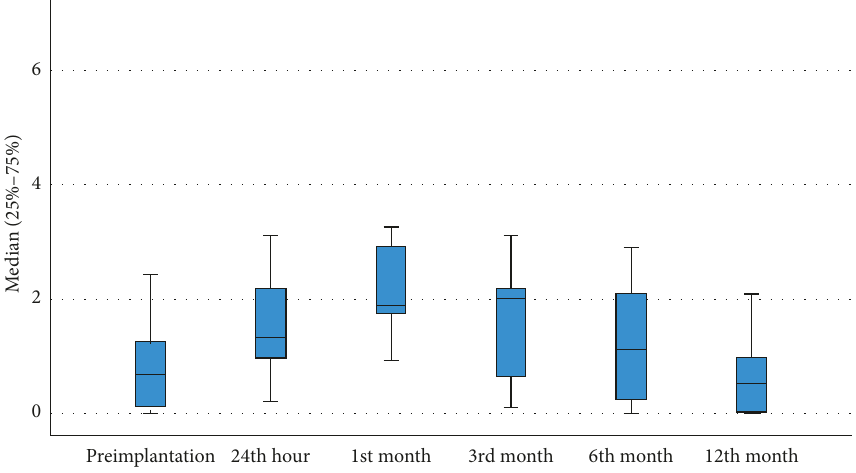
Figure 1: Median serum nickel level at six different time points during the study period. Table 1: Statistical evaluation of serum nickel